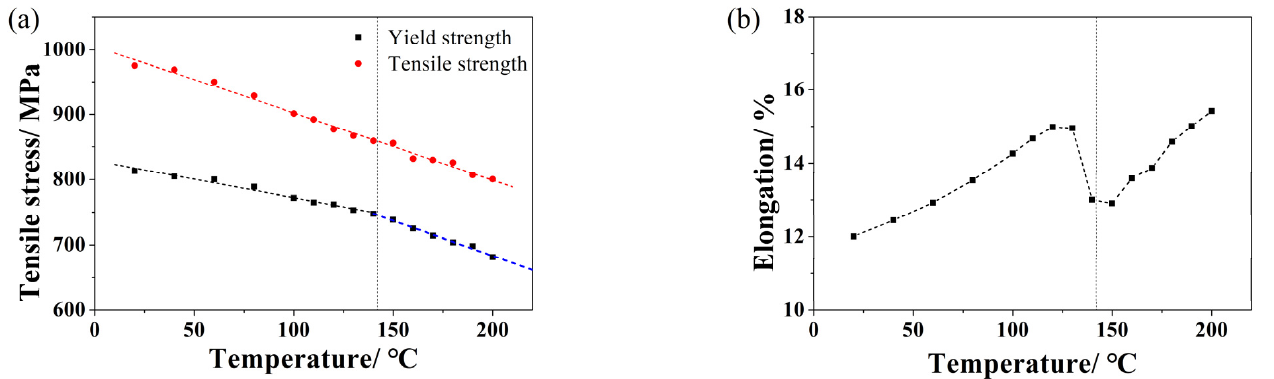
Figure 4. Effect of temperature on mechanical properties: ( a ) yield strength and tensile strength; ( b ) ( b ) elongation.